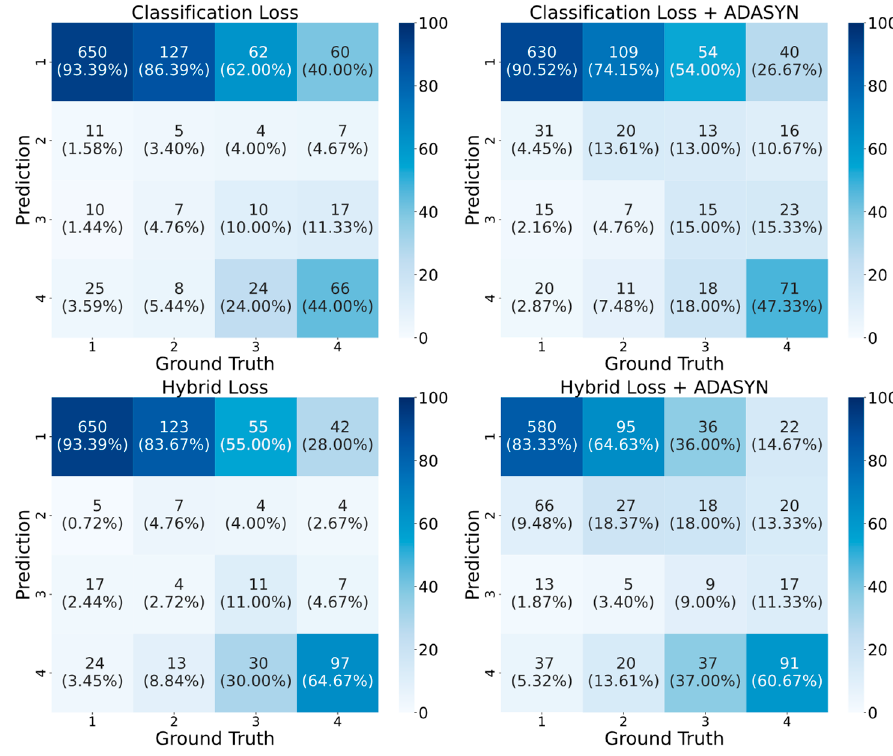
Figure 8. Confusion matrices of combined models based on the methods in the test dataset.